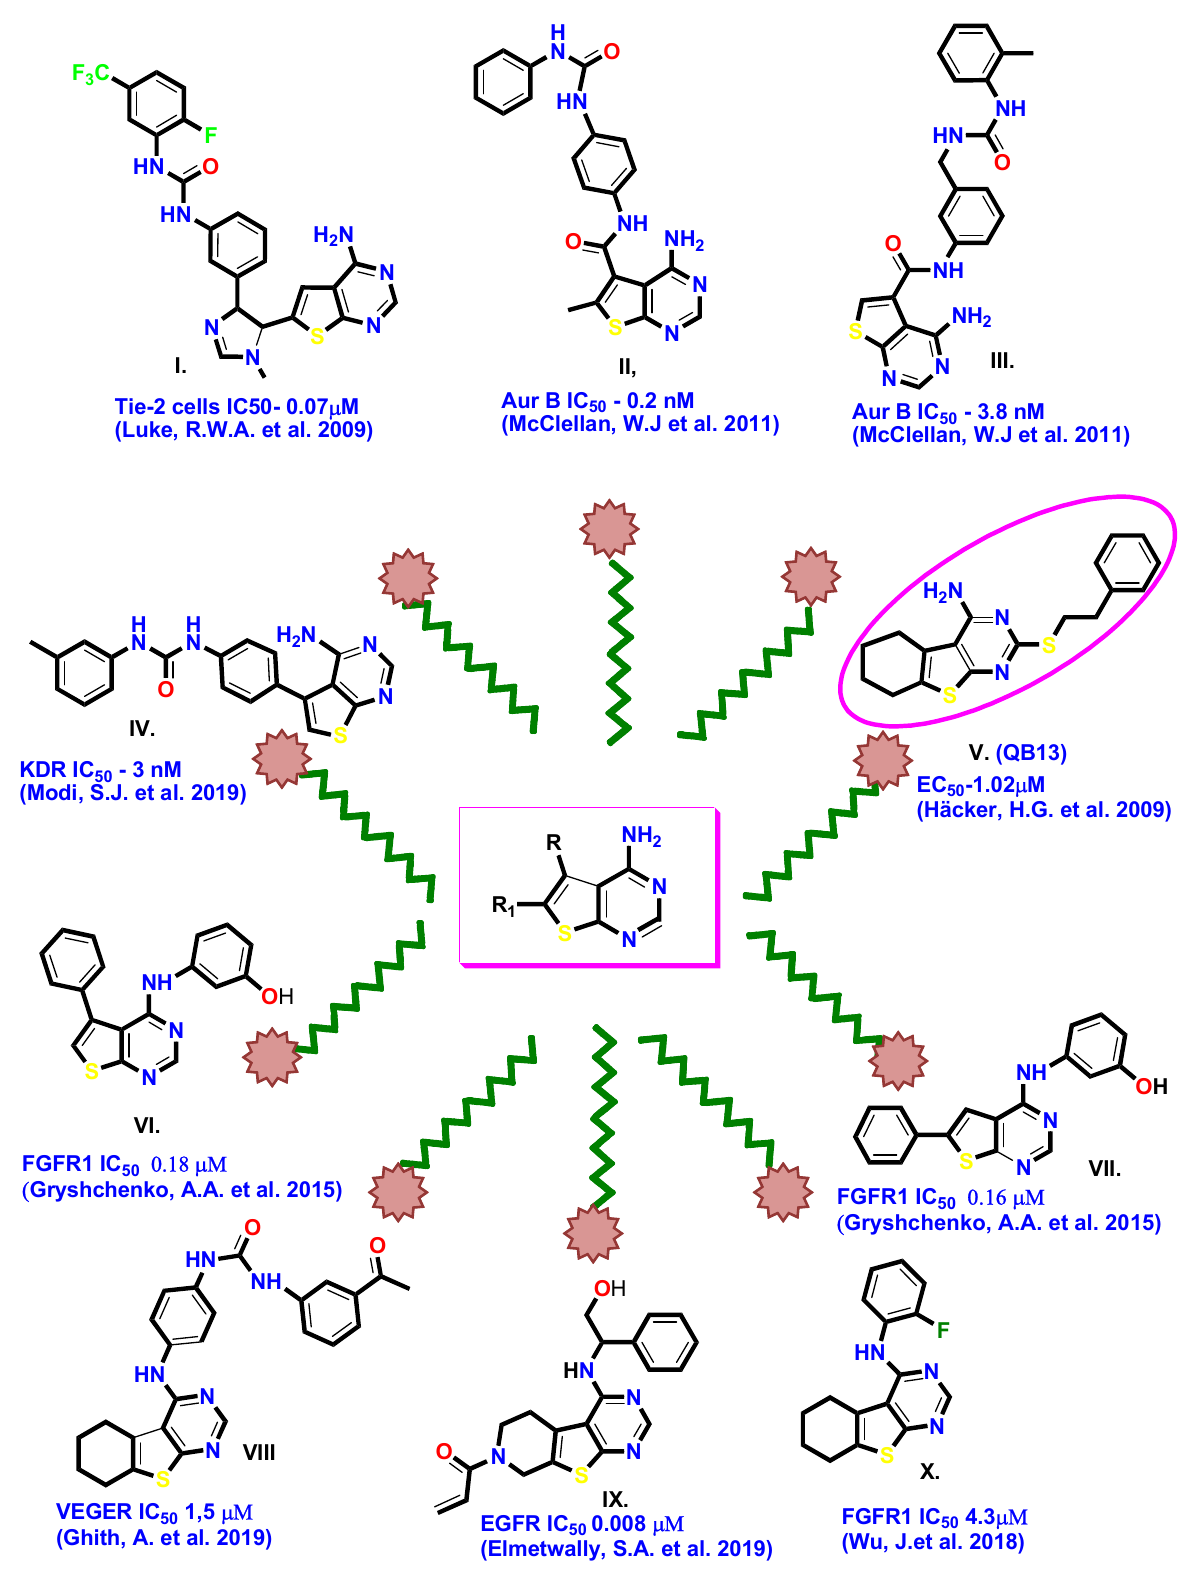
(Figure 1) acts as a modulator of ABC efflux pumps. The EC 50 value of this compound in the daunorubicin accumulation assay was 1.02 µM. Through modification of the structure of QB13, a series of 4-amino-thieno [2,3-d]pyrimidines was designed, synthesized and evaluated as activators of P-gp mediated daunorubicin transport. Structural alteration in of P-gp mediated daunorubicin transport. Structural alteration in different positions of the different positions of the scaffolds was well-tolerated by the transporters [26,27]. scaffolds was well-tolerated by the transporters [26,27].